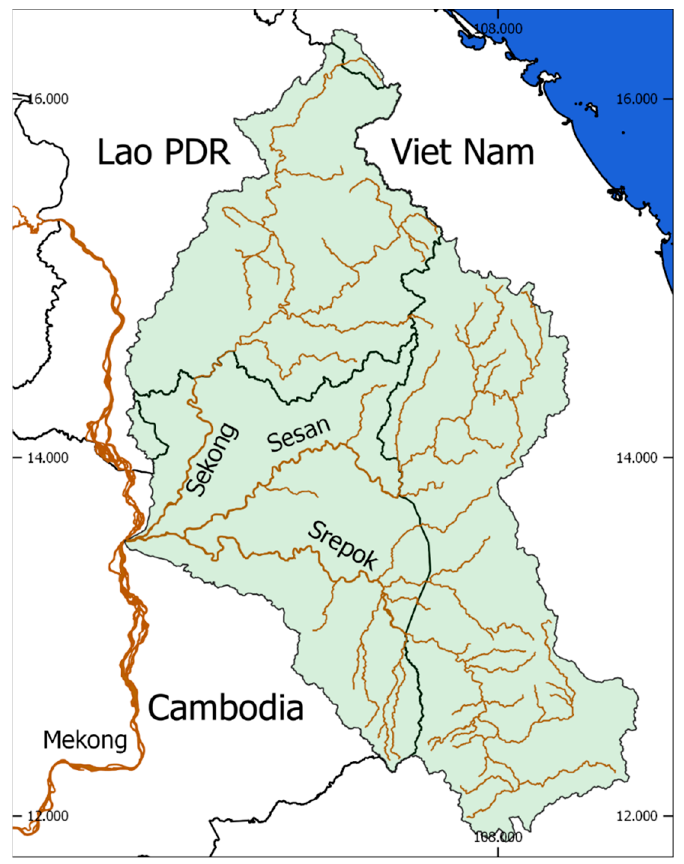
Figure 1. The Sekong, Sesan, and Sre Pok (3S) river basin (highlighted in green).